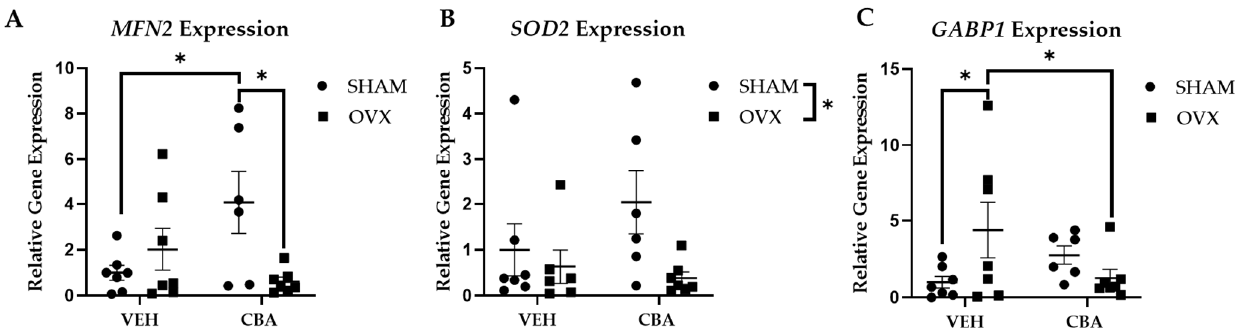
Figure 6. Expression of genes implicated in mitochondrial homeostasis. ( A ). CBA/SHAM had significantly higher Mitofusion 2 ( MFN2 ) expression compared to CBA/OVX ( B ). There was a main effect of OVX to decrease superoxide dismutase 2 (SOD2 ) expression (asterisk represents the main effect of OVX). ( C ). VEH/OVX had increased GA-binding protein subunit beta-1 ( GABP1 ) expression compared to the VEH/SHAM and CBA/OVX groups. Vehicle (VEH)/sham surgery (SHAM) ( n = 8), VEH/ovariectomy (OVX) ( n = 7), chronic binge alcohol (CBA)/SHAM ( n = 7), and CBA/OVX ( n = 7). Two ‐ way ANOVA and uncorrected Fischer’s LSD. * p ≤ 0.05.